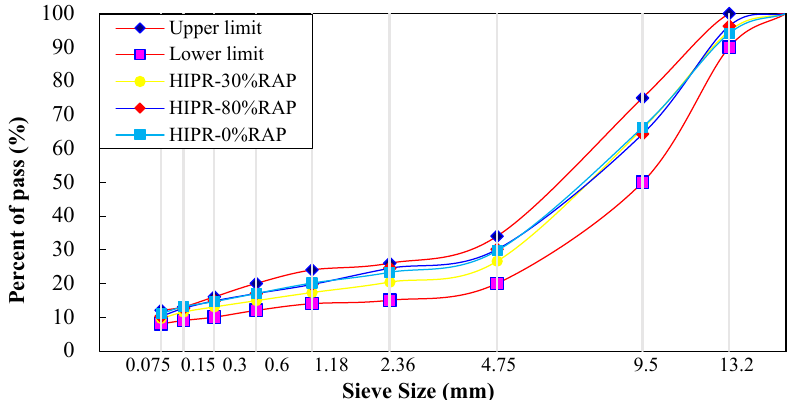
Figure 10. Gradation curves with three maintenance technologies.